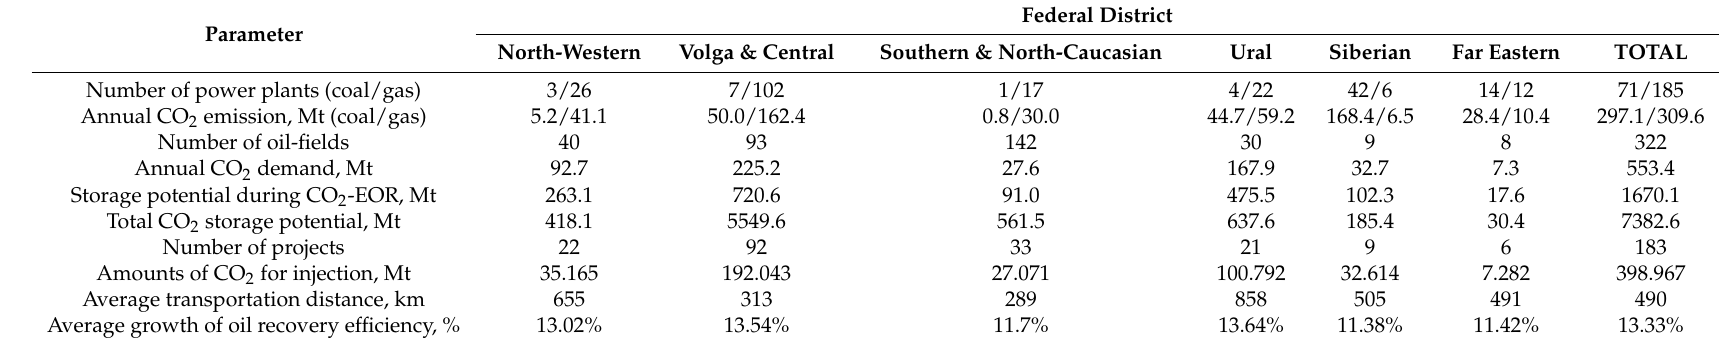
Table 4. Estimated technical potential of Russian regions to utilize anthropogenic CO 2 and promising technical parameters of CO 2 -EOR projects.